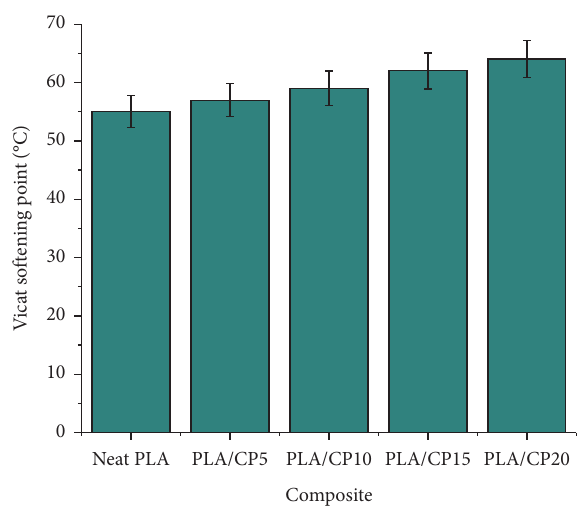
Figure 6: Vicat softening point of